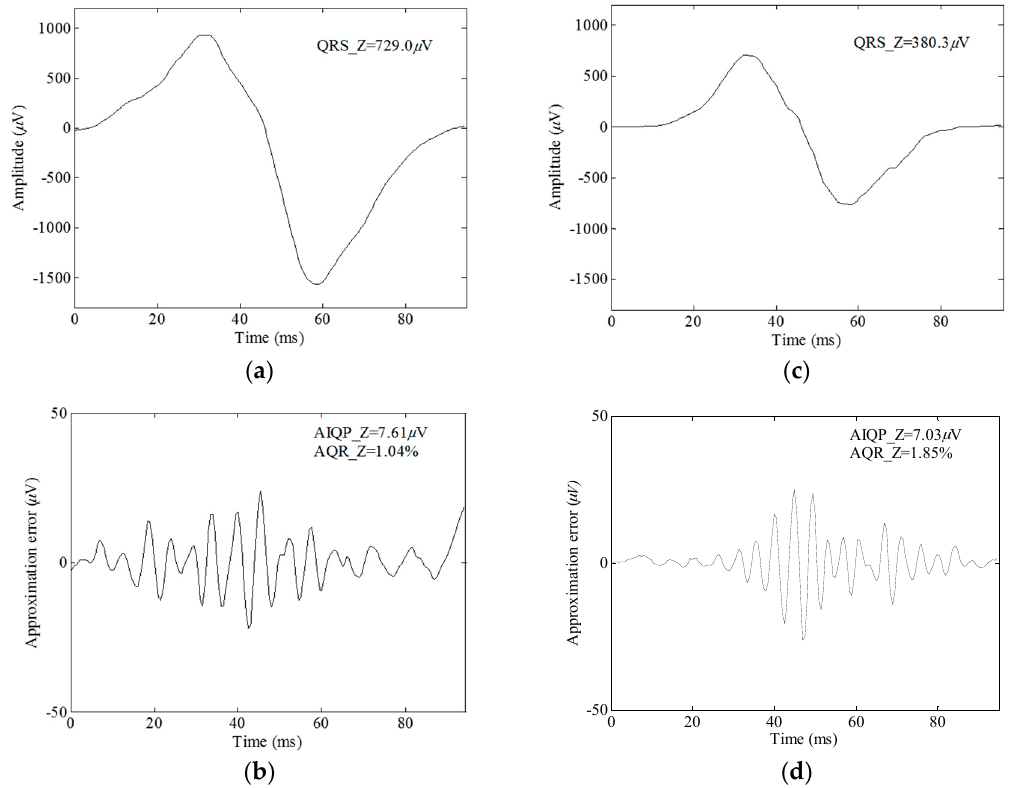
Figure 3. Comparison of the Z-lead QRS waves and approximation errors using an RBFNN(20, 10), ( a ) the QRS wave and ( b ) the approximation error in a normal subject case; and ( c ) the QRS wave and ( d ) the approximation error in a VT patient case.